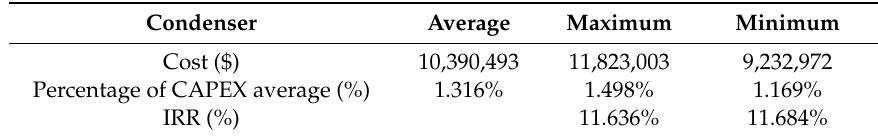
Table 5. Influence of condenser cost on IRR.